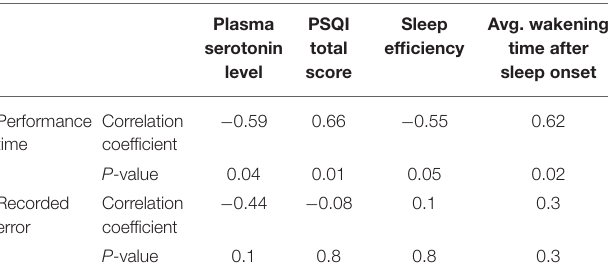
TABLE 5 | Partial correlation in PD participants between motor skill acquisition outcomes and sleep quality measures and plasma levels of serotonin controlling for disease motor severity, cognitive status, daily dose of L-dopa, and depression